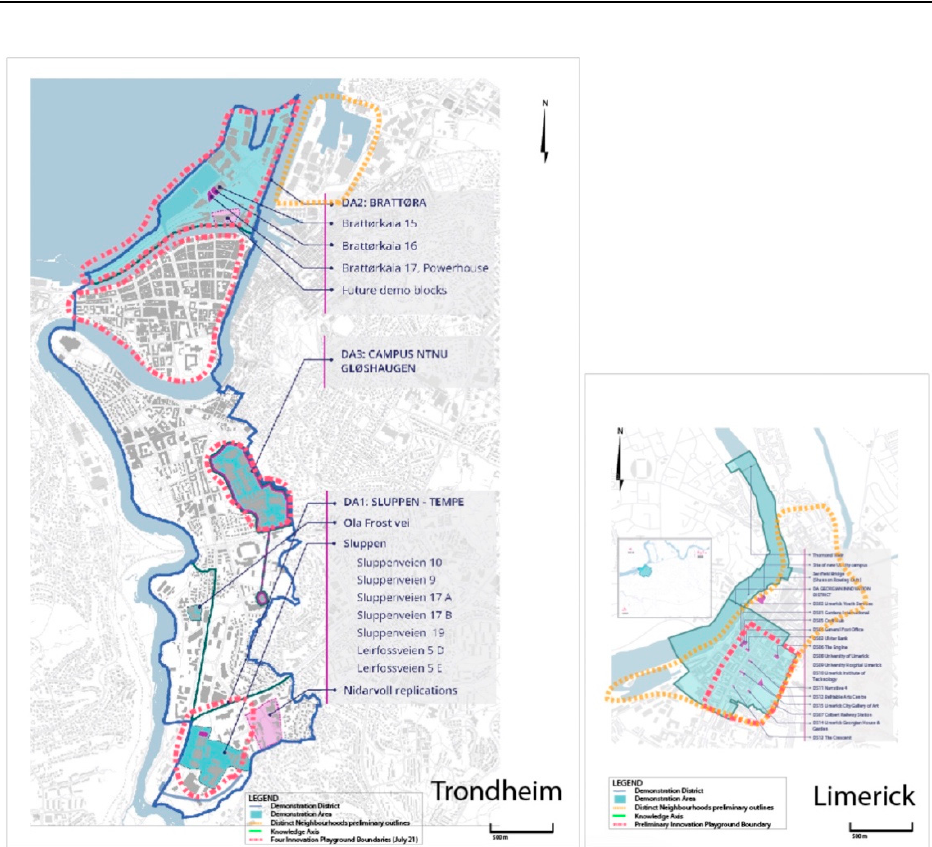
Figure 6. Trondheim and Limerick Innovation Playground Maps (Source: +CityxChange [5]).